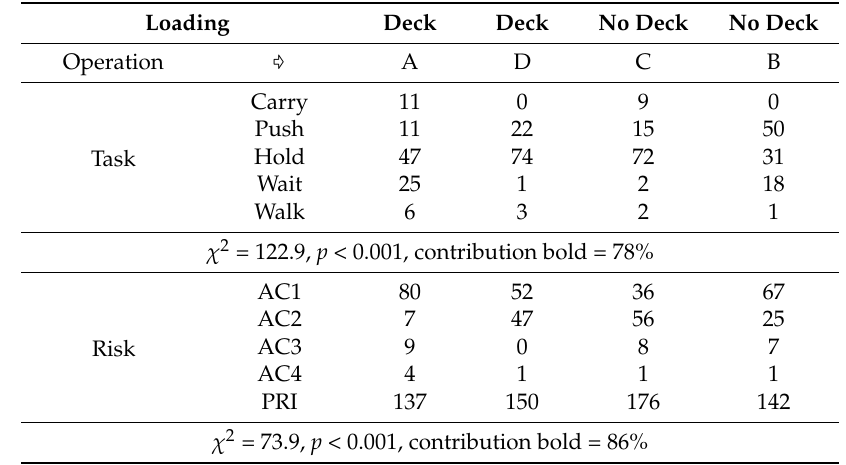
Table 5. Percent distribution of observed frames among task types (above) and postural risk classes (below) at the loading station, for operations with and without a loading deck ( n =